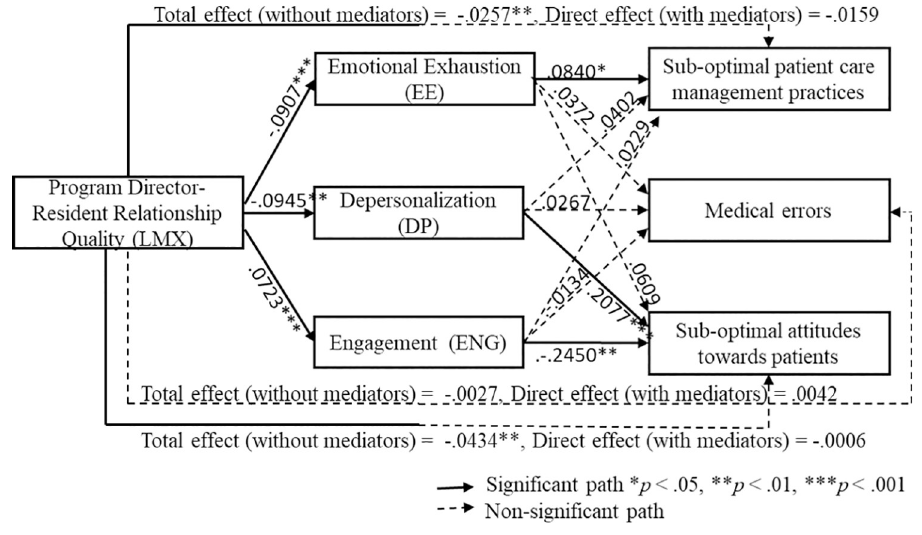
Fig 2. Testing the parallel mediation model for direct effects and total effects.